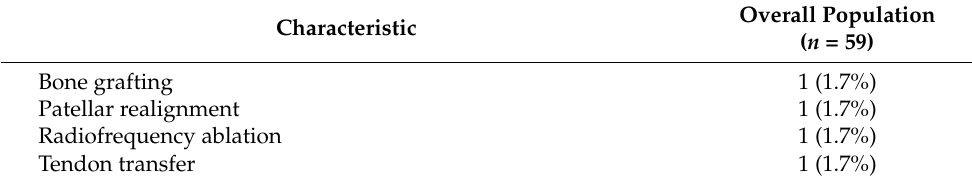
BMI: Body Mass Index; a ACL: Anterior Cruciate Ligament. Table 1. Patient demographics and clinical characteristics.